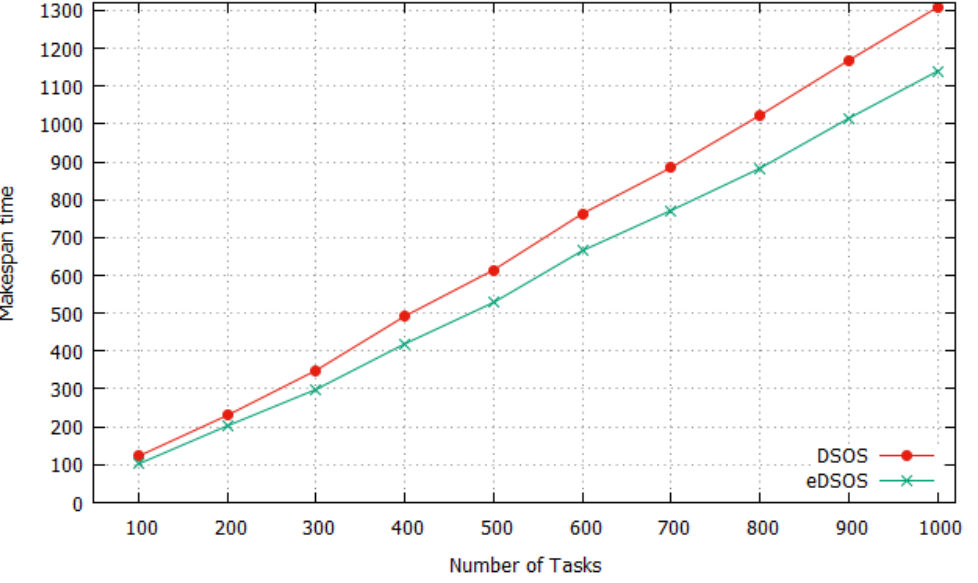
Figure 3. Makespan for dataset with the normal